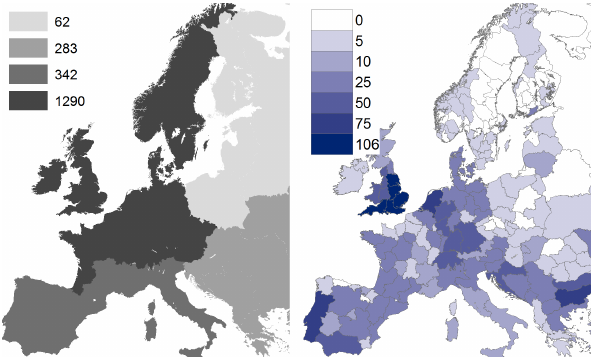
Figure 1. Number of annual aggregated NUTS-combo-scale im- pacts reported and archived in the European Drought Impact Re- port Inventory (EDII) by European macro region (left panel) and by NUTS-combo region (right